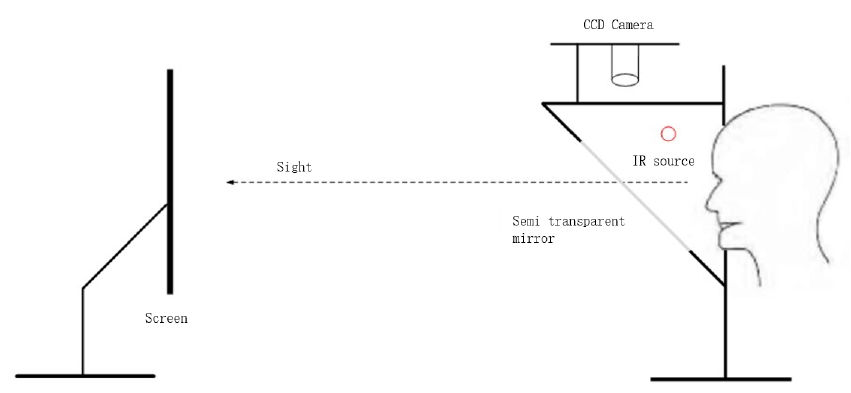
Figure 2. Structure diagram of the head entrust stent.